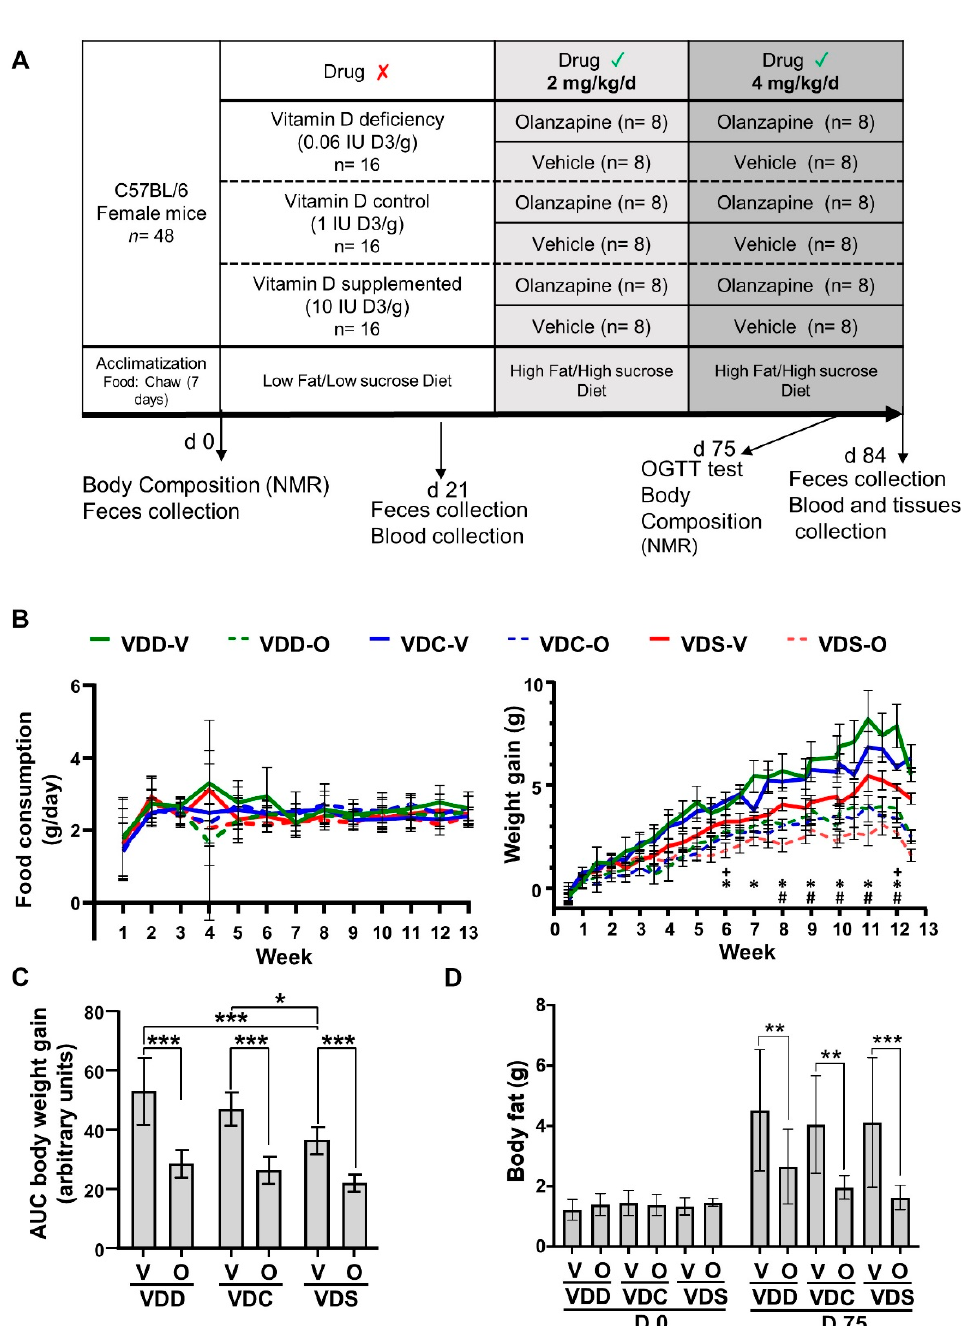
Figure 1. ( A ) Study design. Effect of vitamin D and olanzapine on ( B ) food consumption ( left ) and body weight (right ; +, *, # p ≤ 0.05 for VDD-O vs. VDD-V, VDC-O vs. VDC-V, VDS-O vs. VDS-V, respectively), ( C ) AUC of body weight gain and ( D ) body fat mass of mice treated with olanzapine or vehicle on day 0 and day 77. * p ≤ 0.05; ** p ≤ 0.01; *** p ≤ 0.005. All data are shown as mean ± SD, n = 8 per group). VDD, Vitamin D Deficiency; VDC, Vitamin D Control; VDS, Vitamin D supplemented; O, Olanzapine; V, Vehicle.